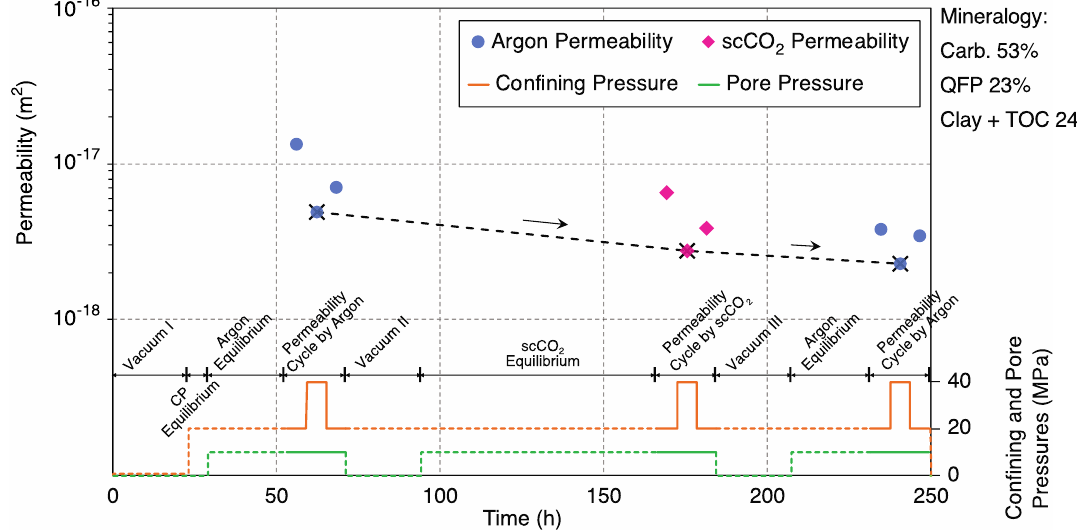
Figure 11. Permeability changes for sample 4-6H. After three days of interaction with scCO 2 , permeability in C2 cycle dropped to 6.51 × 10 − 18 m 2 , exhibiting 7% decrease compared to the last measurement of argon (C1) cycle. This can, in part, be attributed to the higher effective stress of 20 MPa, when the sample is vacuumed for 24 h. Increasing effective stress to 30 MPa results in a substantial permeability decrease by 57% to a value of 2.77 × 10 − 18 m 2 , with a permeability recovery percentage of 59% upon unloading to σ = 10 MPa. Highly pressure-dependent permeability and significant permeability irreversibility upon unloading, alongside with negligible permeability change after three days of scCO 2 interaction indicate that the dominant mech- anism in permeability reduction is mechanical compaction rather than mineral dissolution and/or adsorption, even in the presence of 53% carbonate minerals, 17% clays, and 7% organic matter. This can be attributed to the very low residence time of fluid in the micro- cracks, due to relatively high initial permeability, as opposed to what we observed in the other two Eagle Ford samples, which had similar mineralogical